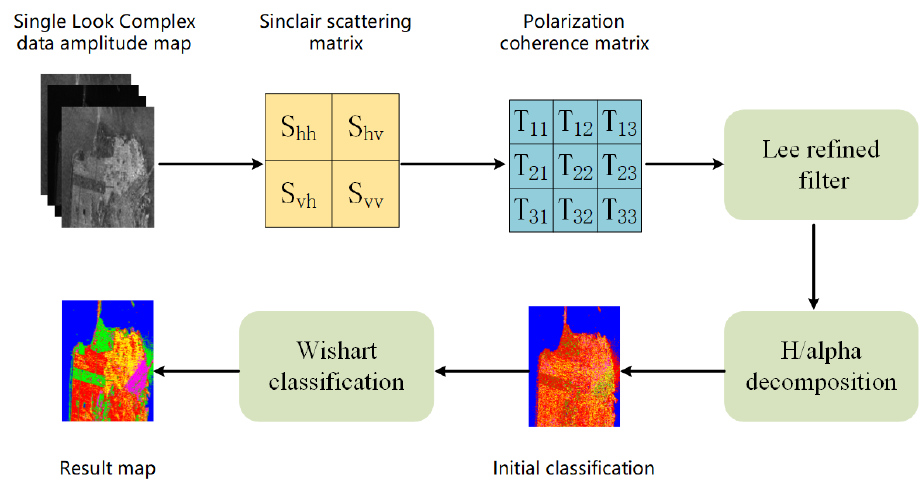
Figure 5. Flow chart of H/alpha-Wishart